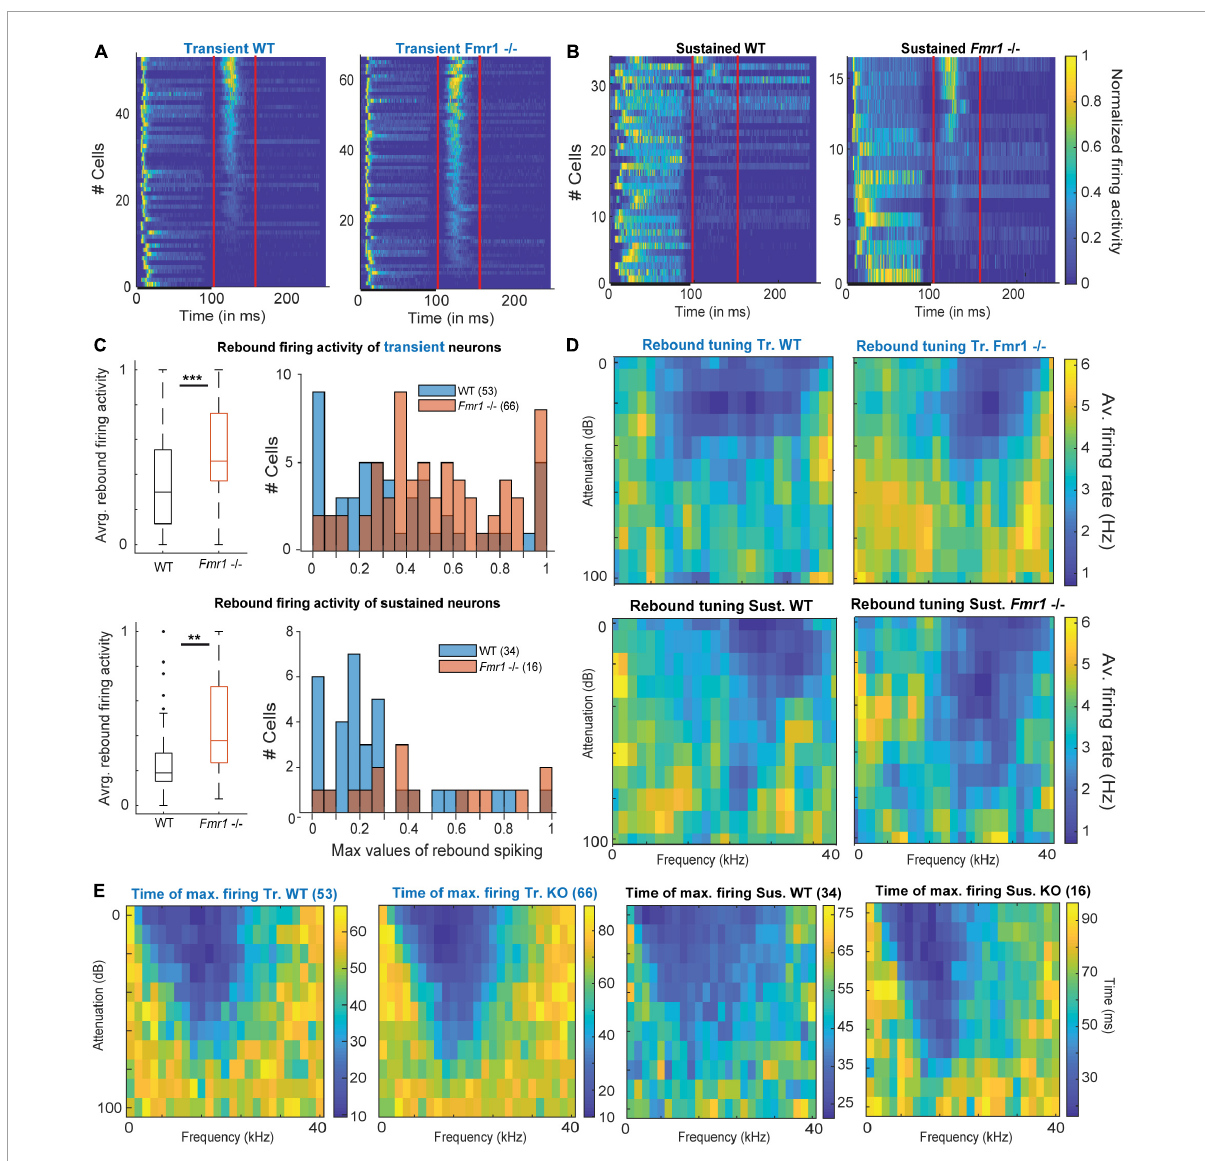
FIGURE5 Offset-rebound activity in Fmr1 -/- neurons. (A) Normalized PSTH for (left) all WT transient neurons and (right) their Fmr1 -/- counterparts; note that the red lines indicate the limits used to quantify the tuning of the rebound-offset activity. (B) Normalized PSTH (left) all WT sustained neurons and (right) all their Fmr1 -/- counterparts. (C) (above left) Averaged and normalized rebound-offset activity in all WT and Fmr1 -/- transient neurons; (above right) Corresponding histograms, note the semi-Gaussian organization of the Fmr1 -/- offset-rebound; (below left) Averaged and normalized rebound-offset activity in all WT and Fmr1 -/- sustained neurons; (below right) Corresponding histogram with a bin size of 0.05. (D) Averaged normalized FRA from spikes selected from offset-rebound activity that illustrates the tuning exhibited by the rebound-offset activity in respectively: (above left) all WT transient neurons, (above right) all Fmr1 -/- transient neurons, (below left) all WT sustained neurons, (below right) all Fmr1 -/- sustained neurons. (E) Similarly for each single individual frequency and attenuation, the time of maximal firing is averaged within the populations and illustrated in the corresponding color code to report the later peak in the PSTH outside of the FRA for (left) Transient WT, (middle left) transient Fmr1 -/- , (middle right) sustained WT and (right) Fmr1 -/-